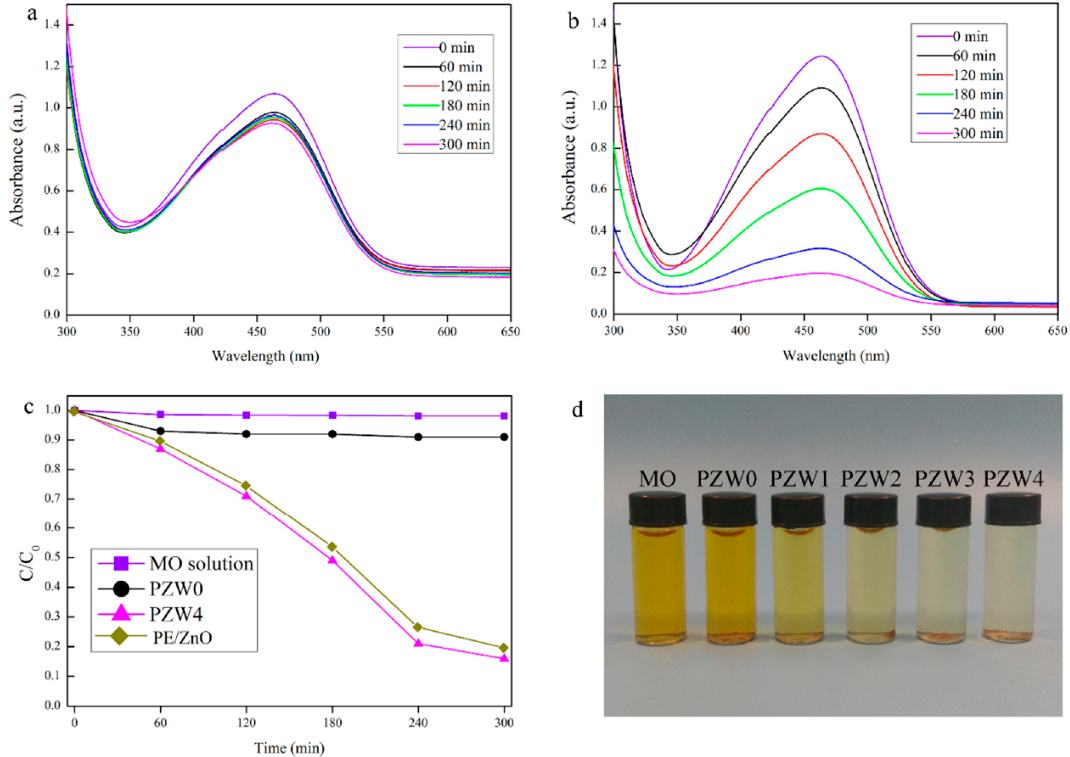
Figure 7. The UV spectra of MO solutions in the presence of the PZW0 powder ( a ) and the PZW4 powder ( b ) under UV irradiation. Photocatalytic activity ( c ) of MO, PZW0, PZW4, and PE/ZnO; ( d ) images of MO, PZW0, PZW1, PZW2, PZW3, and PZW4 under UV light irradiation.